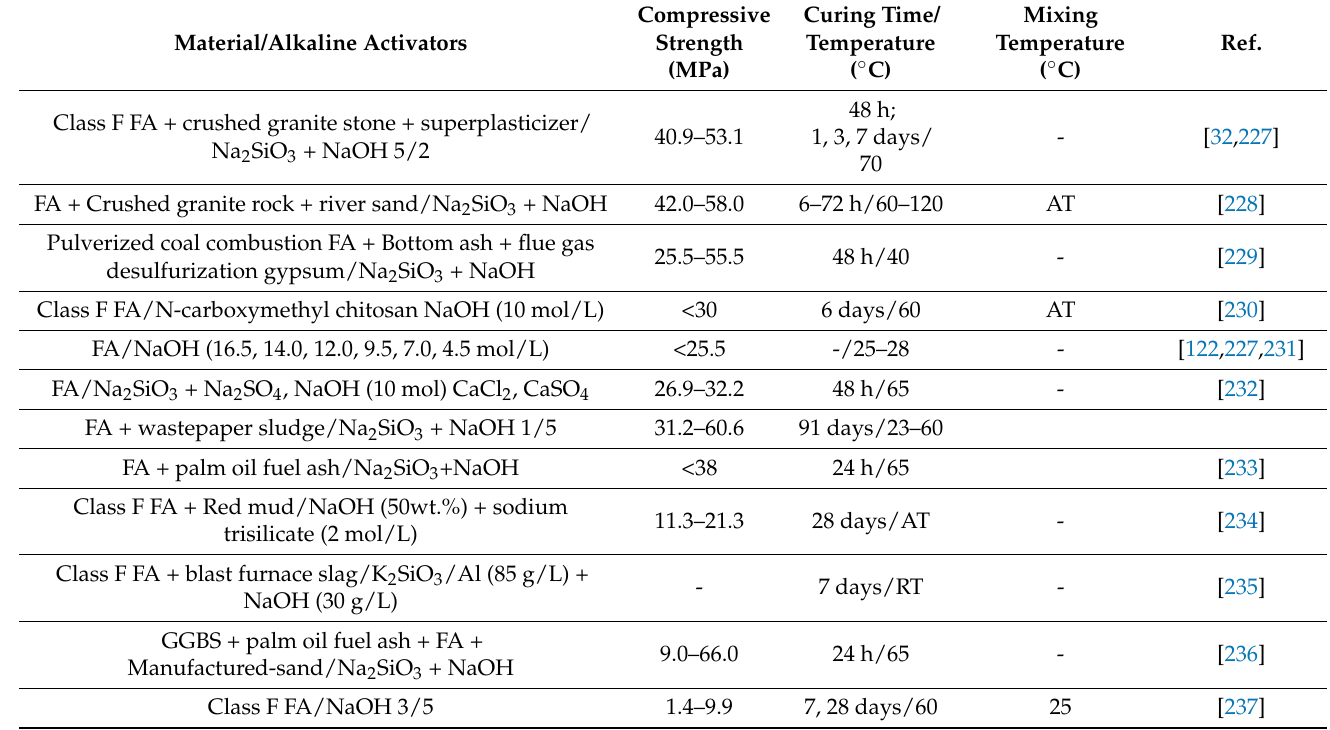
Table 11. Summary of compressive strength of FA-based alkali-activated material (AAM). Compressive Material/Alkaline Activators